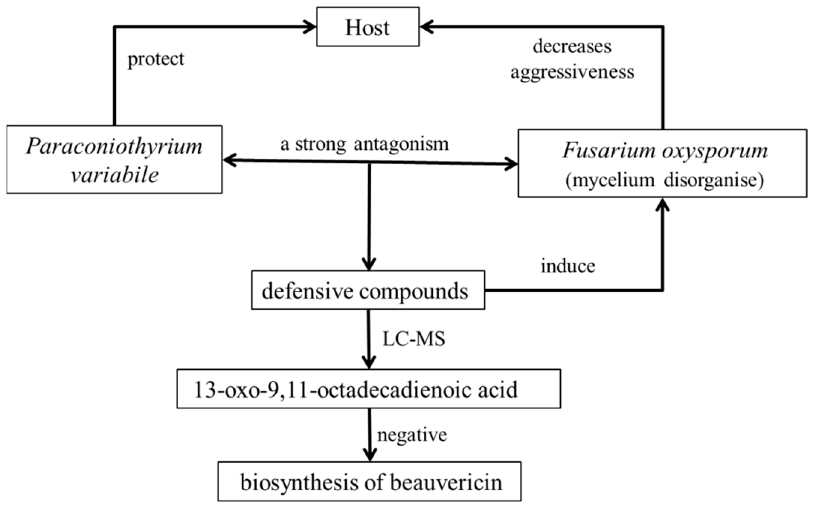
Figure 4. Interactions among Paraconiothyrium variabile , Fusarium oxysporum, and Cephalotaxus harringtonia .